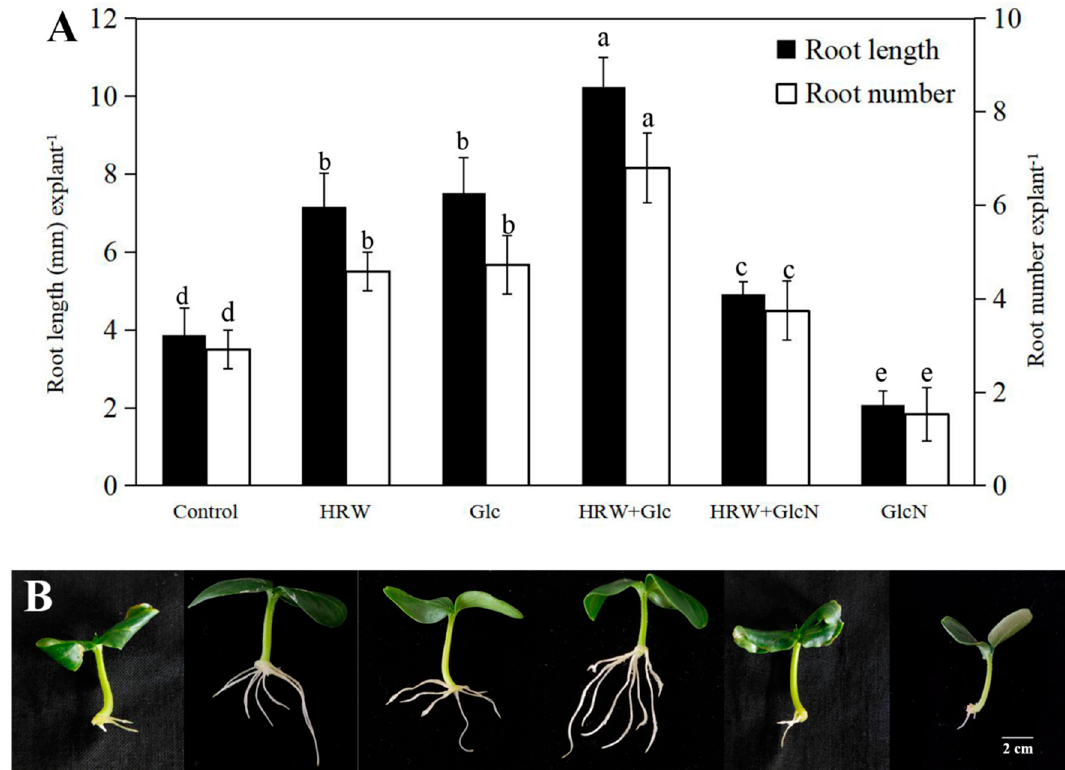
Figure 1 . Effects of HRW, Glc and GlcN on root number and root length ( A ) and phenotype ( B ) of cucumber explants treated with 50% HRW, 0.10 mM Glc and 0.10 mM GlcN alone or together. n = 30 explants per replicate. Bars with different lower case letters were significantly different ( p < 0.5). HRW: hydrogen rich water; Glc: glucose; GlcN: